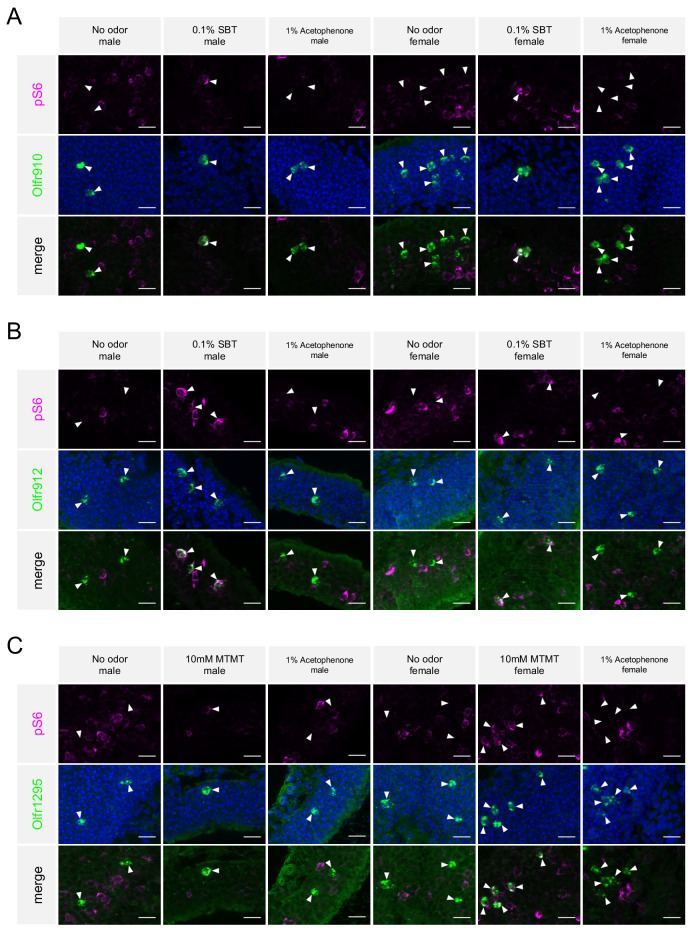
Example in situ stainings showing responses to semiochemicals are not sexually dimorphic between mature male and female mice.(A) Representative images from mature male and female mice showing in situ mRNA hybridizations probing for Olfr910 expression and pS6 immunostainings. Co-localization events are only seen following SBT exposure as indicated by arrowheads. Scale bars indicate 20 μm. (B) Representative images from mature male and female mice showing in situ mRNA hybridizations probing for Olfr912 expression and pS6 immunostainings. Co-localization events are only seen following SBT exposure. (C) Representative images from mature male and female mice showing in situ mRNA hybridizations probing for Olfr1295 expression and pS6 immunostainings. Co-localization events are only seen following MTMT exposure.